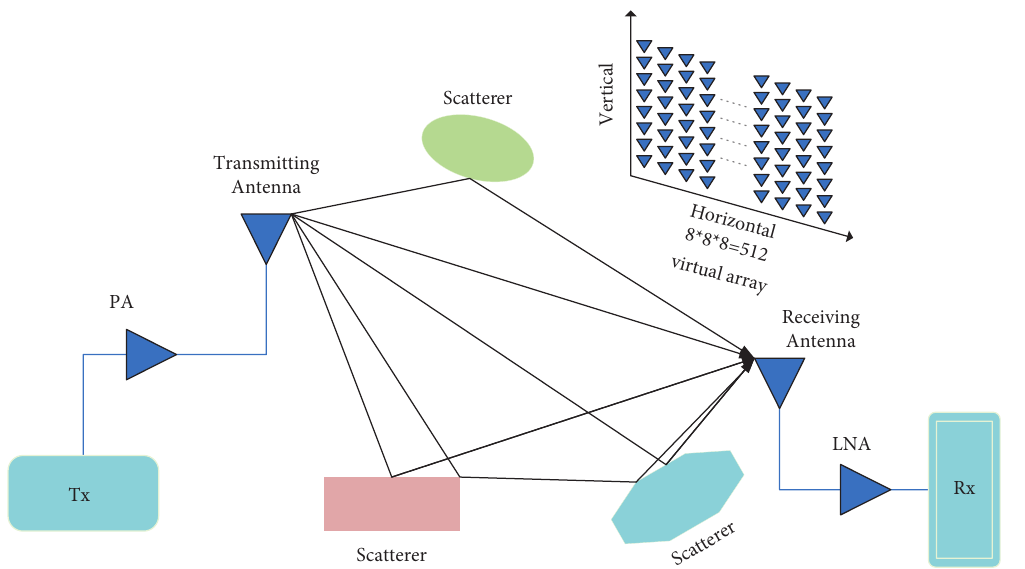
Figure 3: Schematic diagram of virtual array antenna